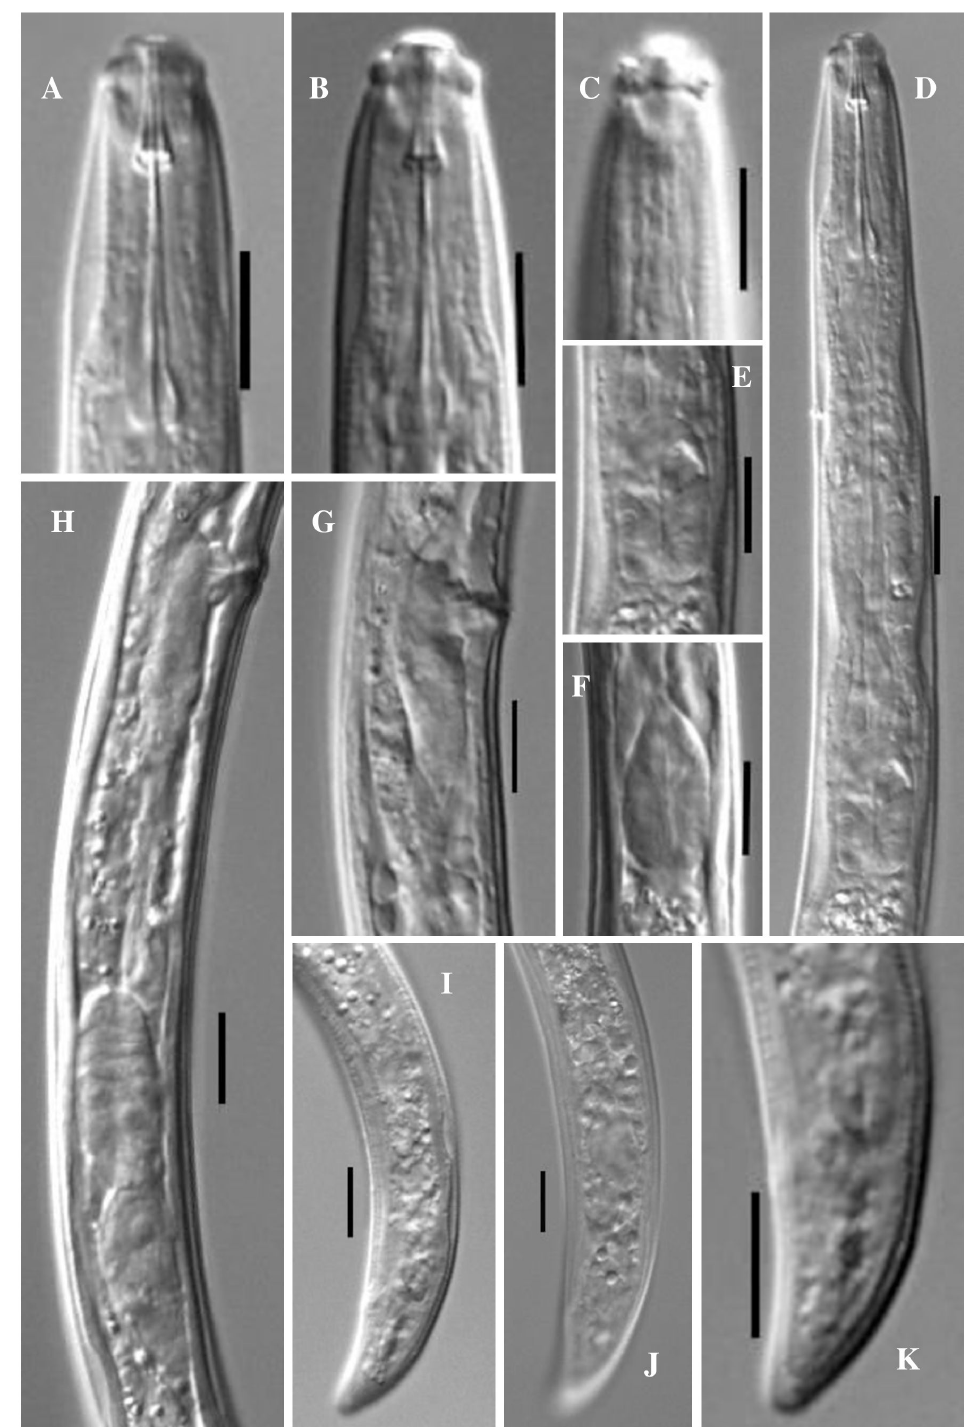
Fig. 11. Basirotyleptus constrictus sp. nov., ♀ (LM photographs). A, C–F, H–I, K . Paratypes (AMU/ ZD/NC/ Basirotyleptus constrictus /2–5). B, G, J . Holotype (AMU/ZD/NC/ Basirotyleptus constrictus /1). A . Paratype 5. C . Paratype 7. D–E . Paratype 5. F . Paratype 2. H . Paratype 1. I, K . Paratype 3. A–B . Anterior region. C . Anterior region showing amphid. D . Pharyngeal region. E–F . Pharyngeal bulb. G–H . Genital system. I–J . Posterior region. K . Posterior end. Scale bars = 10